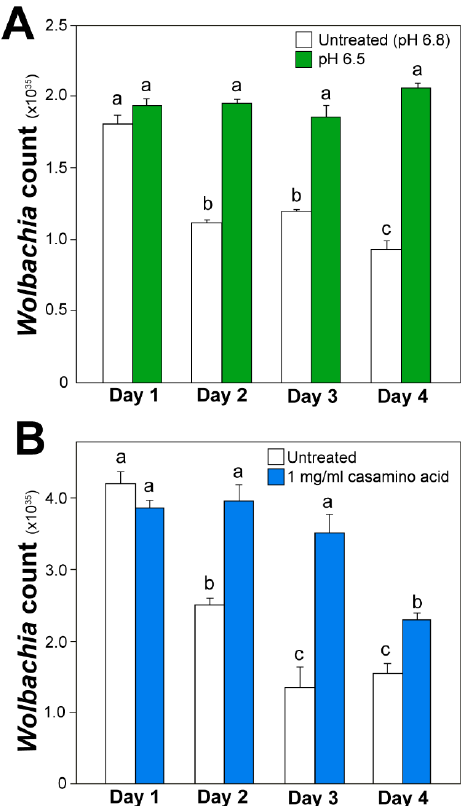
Figure 6. Extracellular Wolbachia count using quantitative polymerase chain reaction (qPCR) in (A) Schneider’s medium with 10% FBS adjusted to a pH of 6.5, and (B) Schneider’s medium with 10% FBS and 1 mg / mL Casamino acids. Significant di ff erences are indicated by di ff erent letters above each bar and 1 mg/mL Casamino acids. Significant differences are indicated by different letters above each bar (Mann–Whitney, p < (Mann–Whitney, p < 0.05).